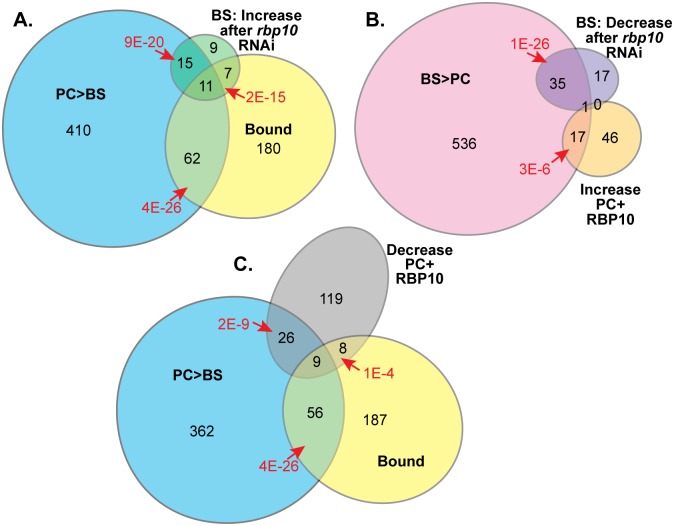
mRNAs bound to and/or regulated by RBP10.Results for mRNA levels are displayed as proportional Venn diagrams made using http://www.eulerdiagrams.org/eulerAPE/. BS = Bloodstream form, PC = procyclic form. Categories were: Bound: S2 Table sheet 2. PC>BS and BS>PC: at least 2x significantly regulated in polysomal RNA. Values for increases after rbp10 RNAi in bloodstream forms (at least 2x significantly regulated), or RBP10-myc expression in procyclic forms (at least 1.5x significantly regulated), are from S3 Table. All data are from Lister 427 strain parasites. A) RBP10-bound mRNAs relative to those that are more abundant in procyclic forms and/or increase after rbp10 RNAi. B) Overlaps between mRNAs that are more abundant in bloodstream forms, and those that decreased after rbp10 RNAi in bloodstream forms or increased after RBP10 expression in procyclic forms. C) Overlaps between bound RNAs, procyclic-specific mRNAs, and the mRNAs that decreased after RBP10 expression in procyclic forms.